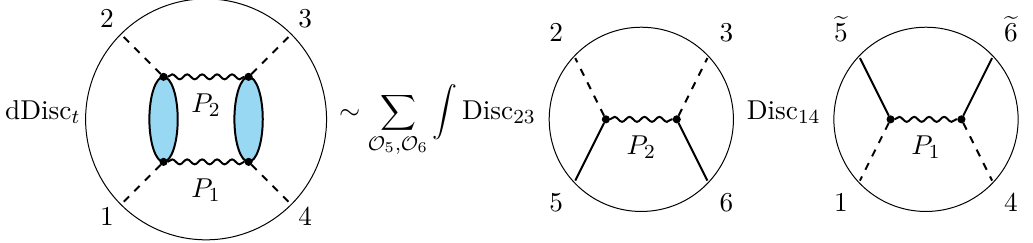
Figure 4 . Optical theorem in the Regge limit in terms of Witten diagrams. The tree-level cor- relators are dominated by s -channel Pomeron exchange. The external operators are scalars, while O 5 and O 6 are summed over all states that couple to the external scalars and the Pomeron (tidal excitations). The ellipses on the l.h.s. indicate that all string excitations are taken into